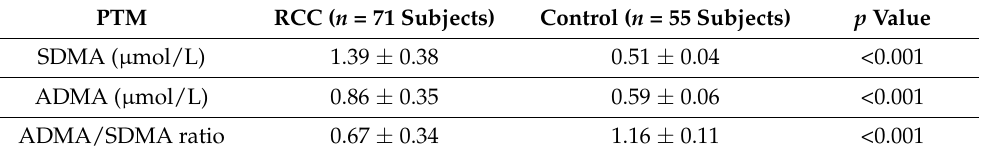
Table 4. Protein methylation status in the studied groups.